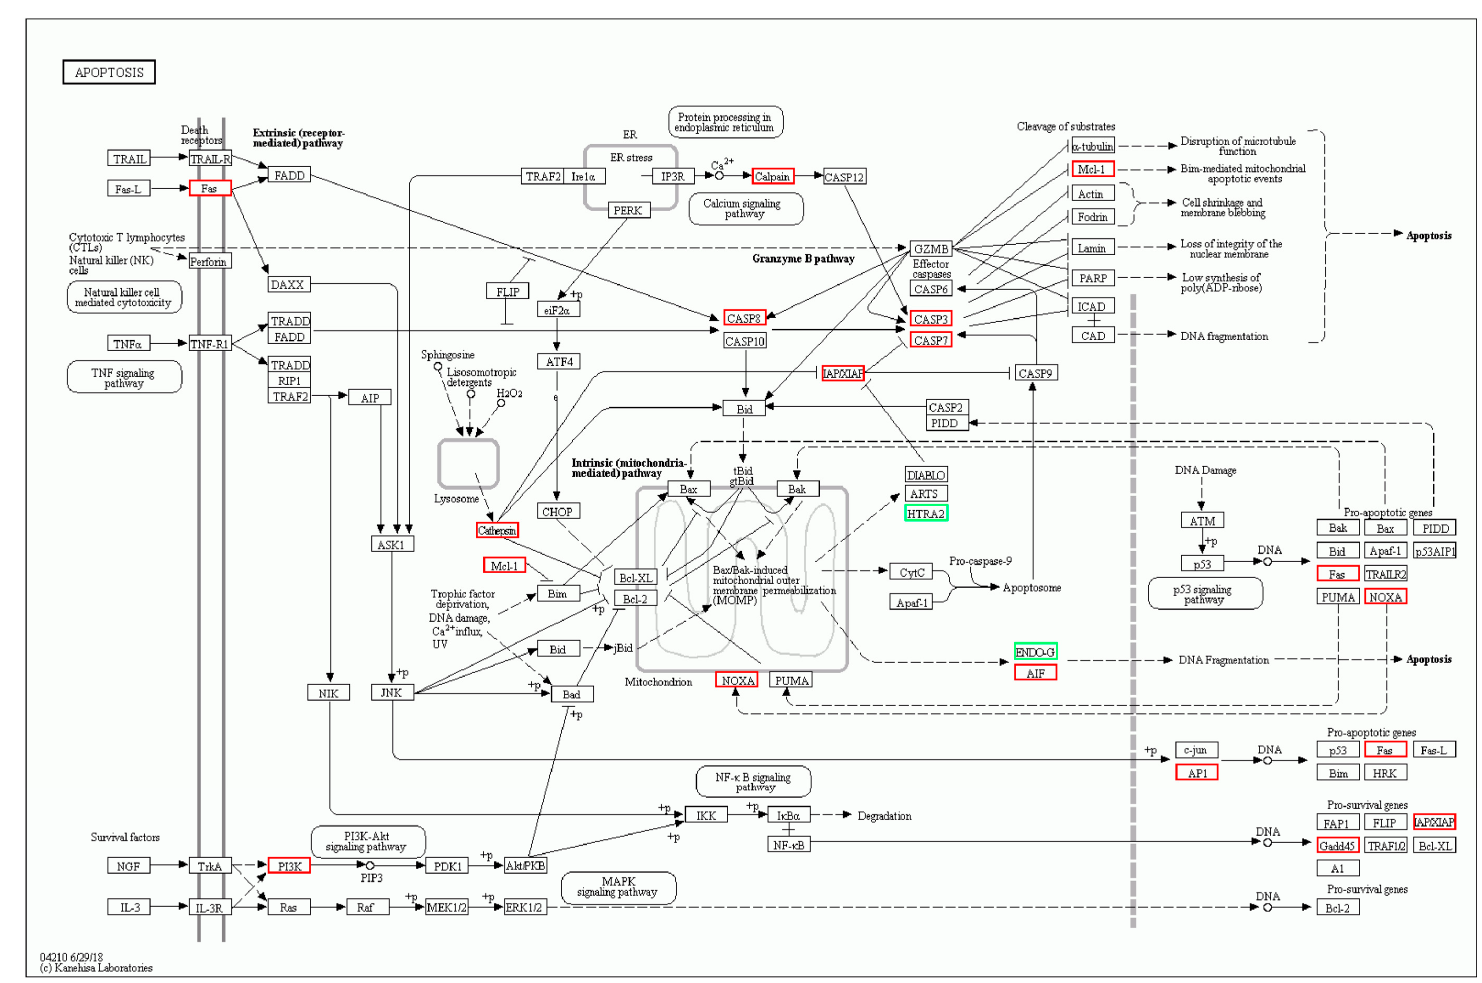
Figure 11. The di ff erentially expressed genes involved in the apoptosis pathway were annotated by KEGG. The DEGs included fas , aiftm4 , casp3b, casp3l, casp8l2, pmaip1, fosaa , fosab , pik343a, LOC101886621, ctss2.1, gadd45aa, gadd45ba, gadd45bb, mcl1b, zgc:162184, pik3r3a and xiap . Red and green indicate up- and downregulation of gene expression,